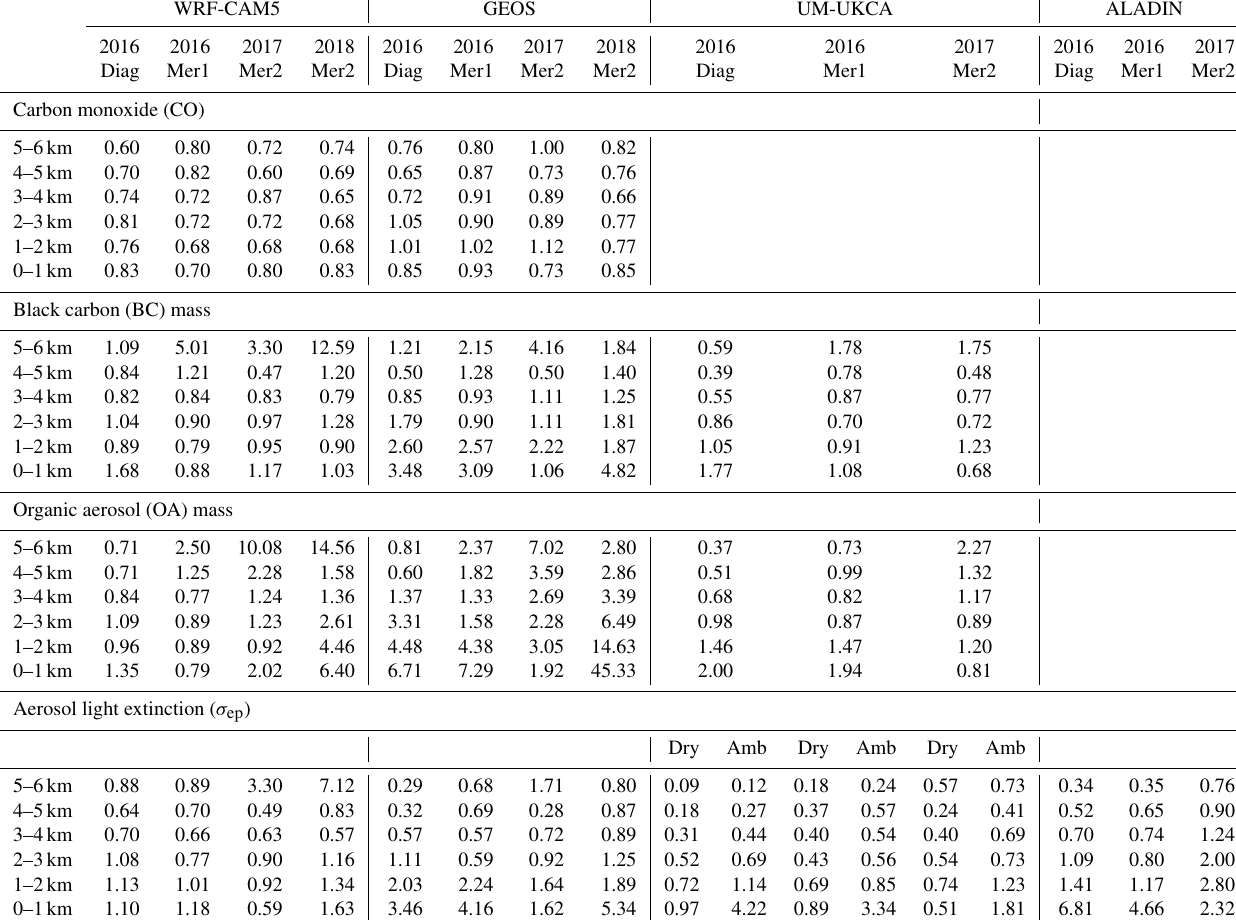
Table 1. Median across each comparison transect of modeled-to-observed ratios for extensive parameters averaged within 1km deep altitude bins. Shown are median biases for CO concentrations, BC mass, OA mass, and σ ep as measured in situ from the P-3 aircraft. Observed values of σ ep are at 530nm and for low RH ( < 40%) aerosol, whereas modeled values are at 550nm and ambient RH, except for UM-UKCA, which reports σ ep for both the dry and ambient RH